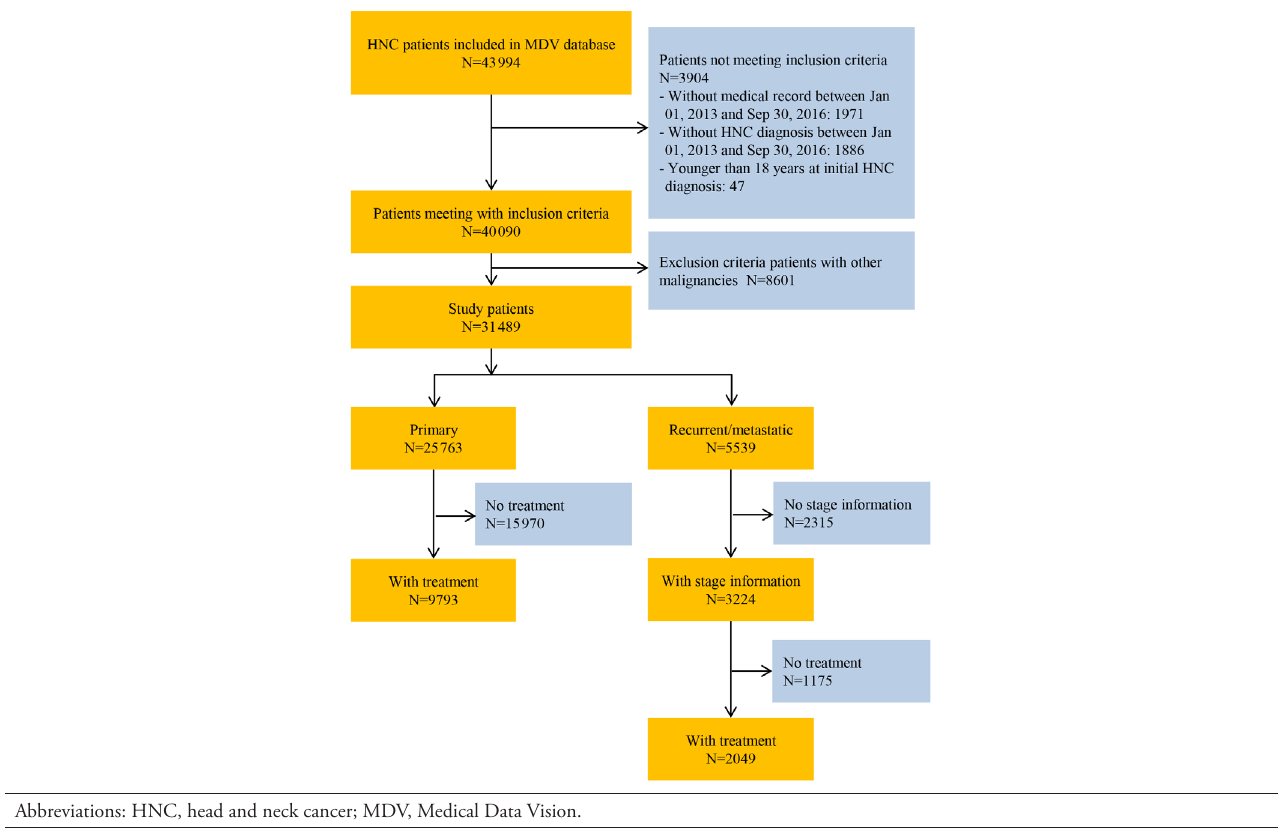
Figure 1. Patient Flow Diagram (Primary and Recurrent or Metastatic HNC)